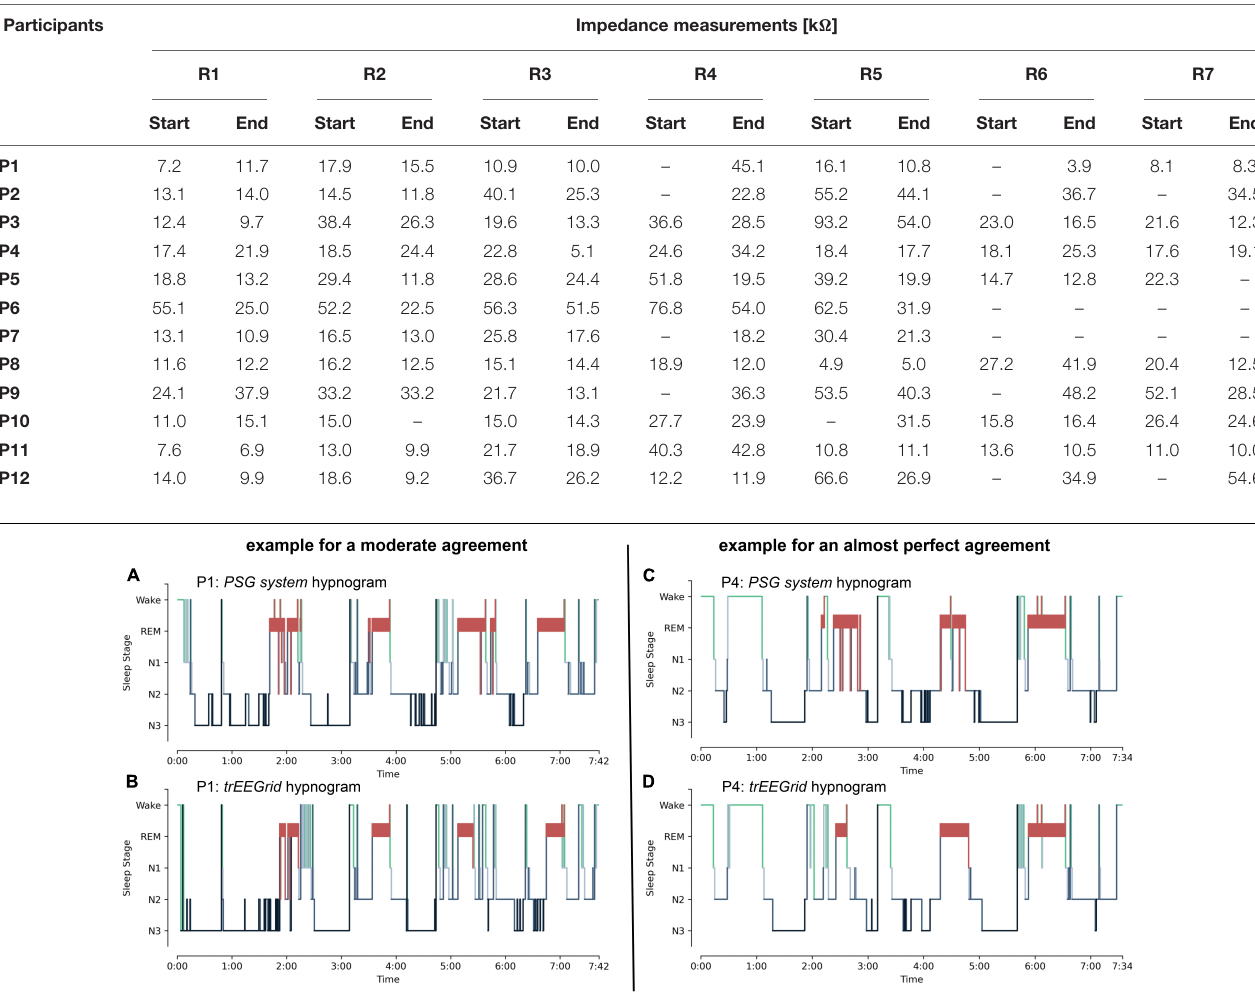
TABLE 2 | trEEGrid system impedances at the start and end of night measurements in the validation study in k (cid:127) (impedances above 100 k (cid:127) are marked as “-”). Participants